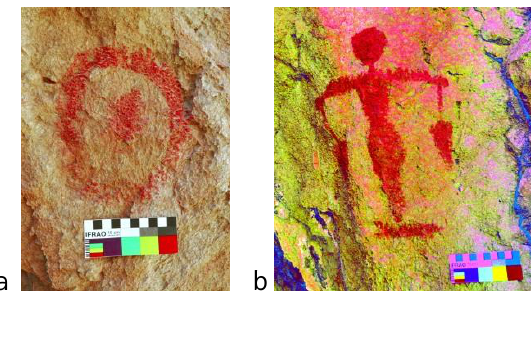
Figure 12. Kuh-e-Donbeh, Site IV. ( a ) Geometric mark. ( b ) Anthropomorphic depiction. (Both illustrations are enhanced using